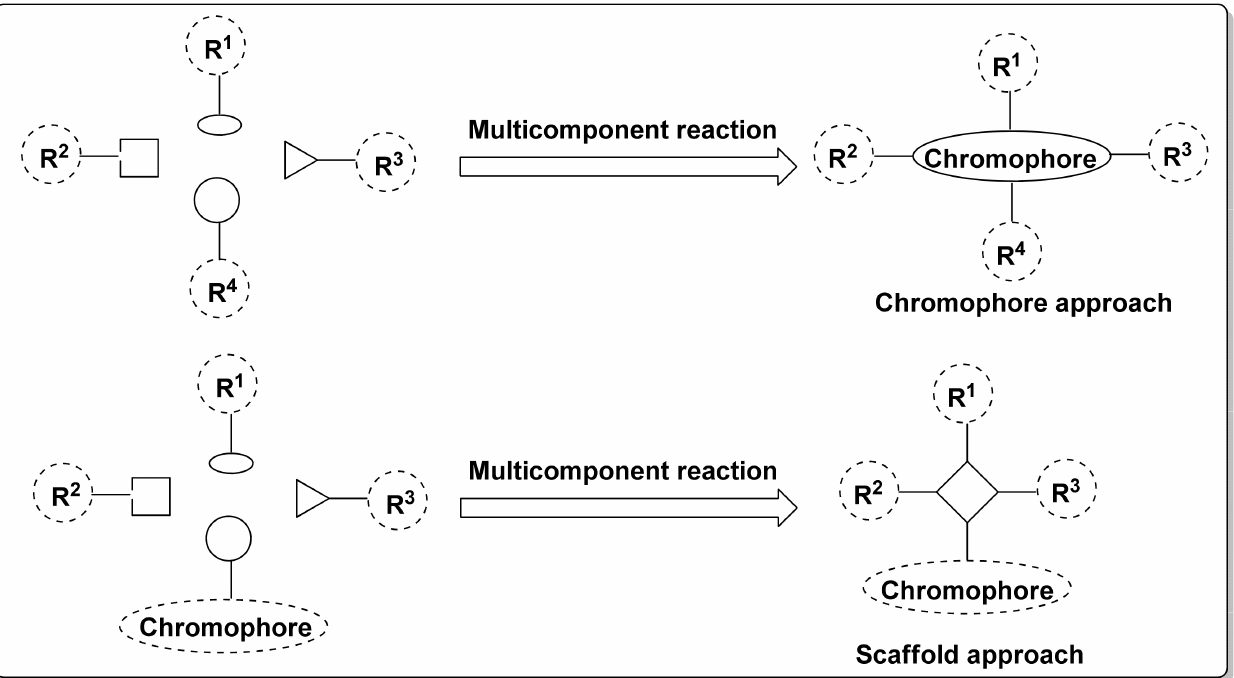
Figure 1. Conceptual chromophore and scaffold approaches for MCR